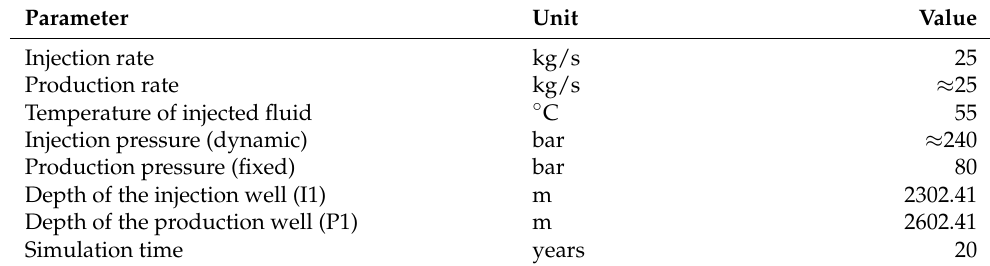
Table 4. Summary of the production parameters for the reference simulation case [2].